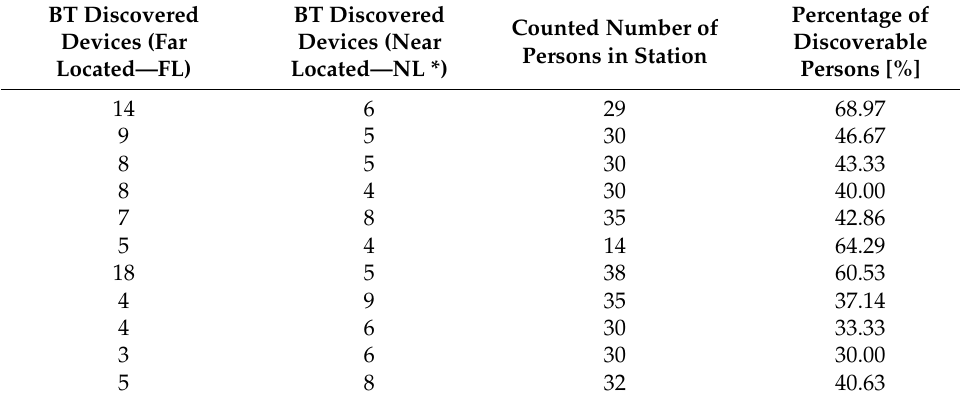
Table 2. Values recorded in Subway Station 1.